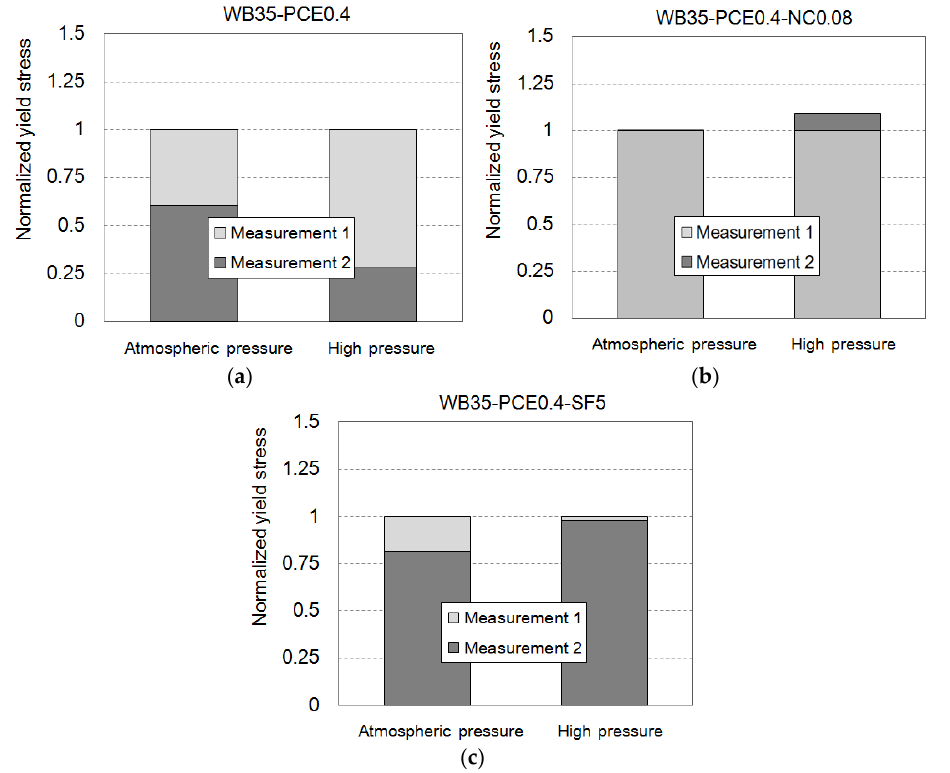
Figure 8. Normalized yield stress of the cement paste with ( a ) superplasticizer, ( b ) nanoclay, and ( c ) silica fume under atmospheric pressure and high pressure. ( c ) silica fume under atmospheric pressure and high